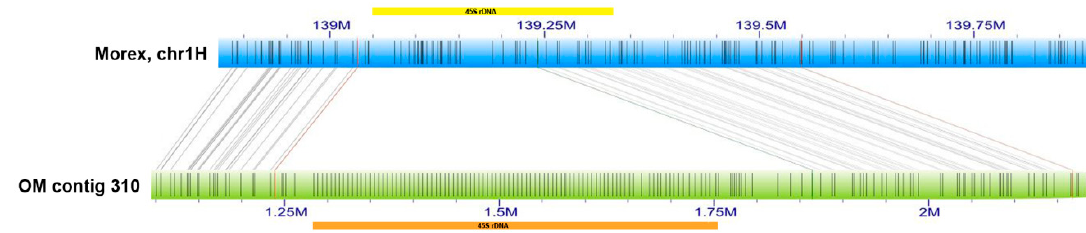
Figure 4. Positioning of the 45S rDNA locus in barley chromosome1H. Alignment of barley ‘Morex’ 1H pseudomolecule [2] (blue bar) to ‘Morex’ OM contig 310 (green bar) revealed a tandemly organized repeat with ~5 kb label spacing (highlighted by orange bar) missing in the pseudomolecule. Co-localisation with a cluster of 45S rDNA fragments in the sequence assembly (highlighted by yellow bar) indicates that the array represents the 1H rDNA locus.